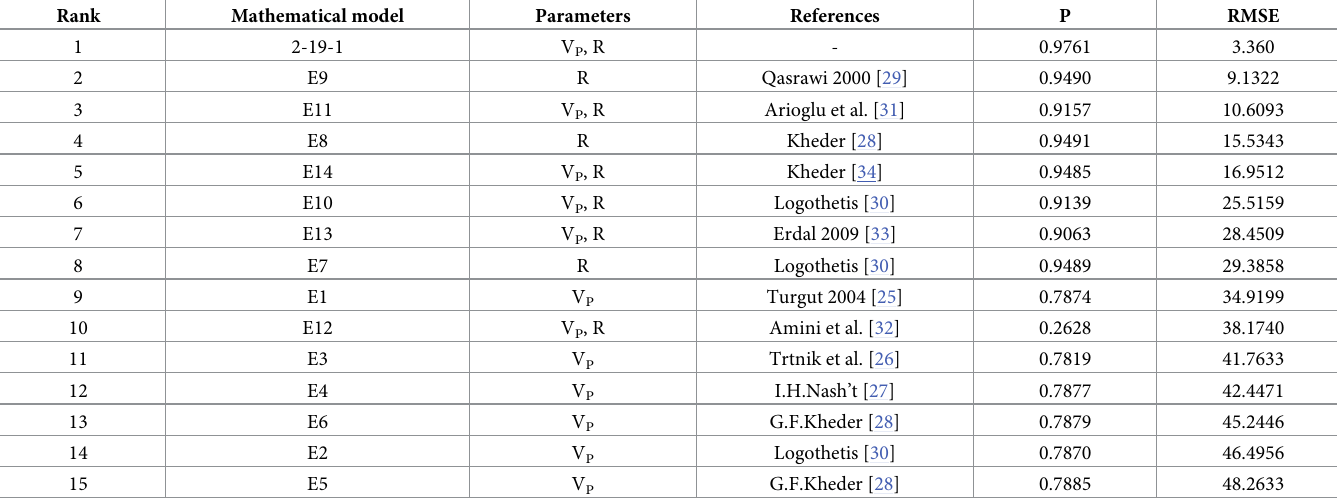
Table 12. Models for concrete compressive strength prediction ranked according to